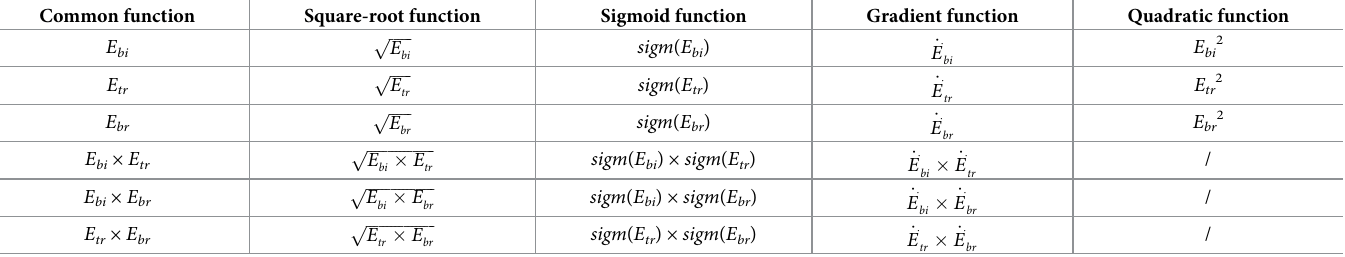
Table 3. Set of candidate functions of FOS muscle force prediction model, which comprises the common, quadratic, square-root, sigmoid, and gradient function sets. Common function Square-root function Sigmoid function Gradient function Quadratic